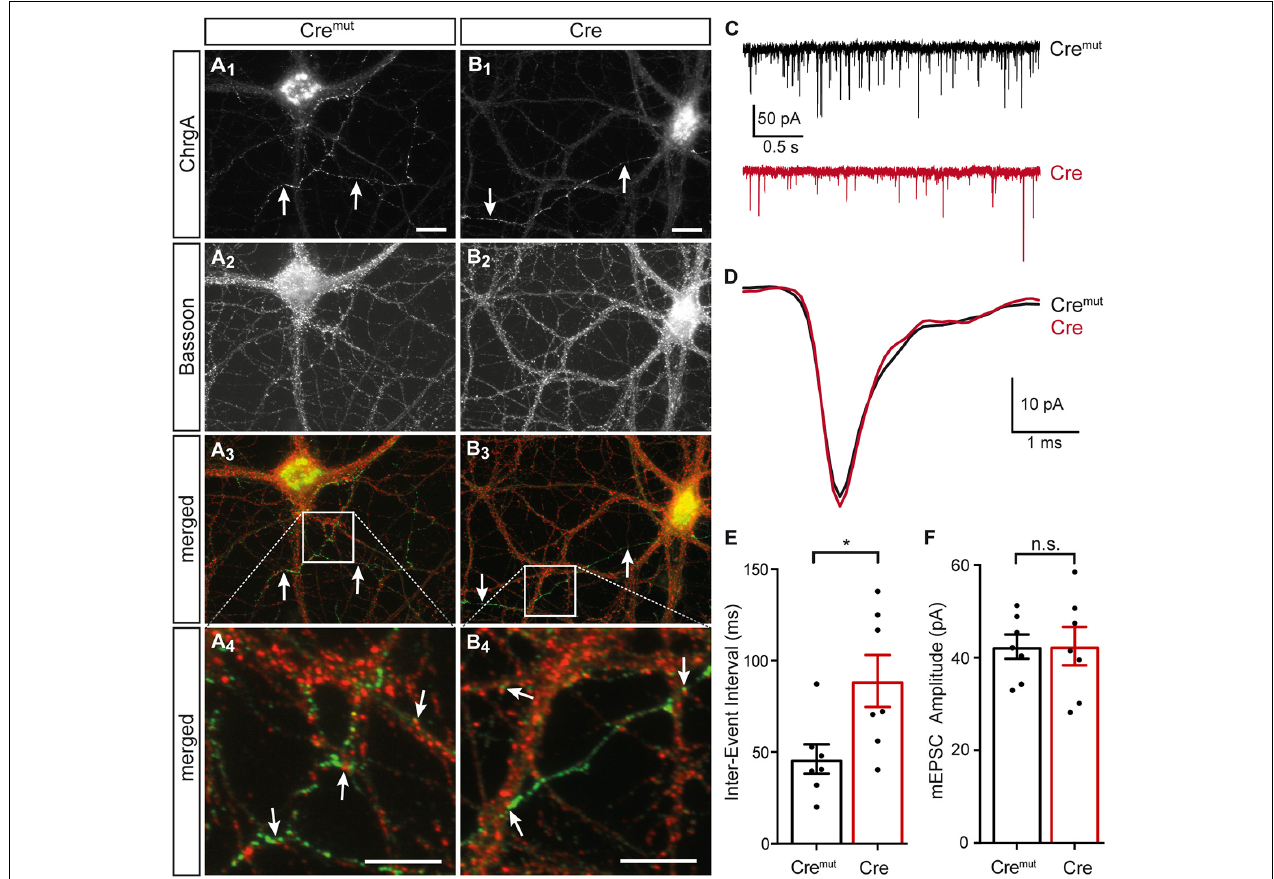
FIGURE 3 | Normal ChrgA-to-Bassoon alignment in synapses of β -Nrxn-deficient neurons. (A,B) Primary hippocampal neurons from floxed β -KI mice were transduced with lentivirus expressing inactive Cre mut (A 1 –A 4 ) or active Cre recombinase (B 1 –B 4 ) and immunostained at DIV18 with anti-ChrgA (arrows, A 1 ,B 1 ) and anti-Bassoon ( A 2 ,B 2 ). Merged images ( A 3 ,B 3 ) show the more restricted expression of the DCV marker ChrgA (arrows, green label) in comparison to the ubiquitous punctate distribution of the presynaptic marker Bassoon (red label). Note the juxtaposed localization of these molecules in high magnification images (arrows, A 4 ,B 4 ). Scale bars in panels (A 1 ,B 1 ) for panels (A 1 –A 3 ,B 1 –B 3 ) : 20 µ m; scale bars in panels (A 4 ,B 4 ) : 8 µ m. (C) Representative traces of whole-cell patch clamp recordings of pharmacologically isolated miniature excitatory postsynaptic currents (mEPSCs) show a visibly reduced frequency of mini events in β -Nrxn-deficient (Cre, red) neurons compared to controls (Cre mut , black). (D) Averaged individual mEPSC traces from more than 100 consecutive events reveal similar amplitudes and kinetics in β -Nrxn-deficient (Cre, red trace) neurons compared to controls (Cre mut , black trace). (E,F) The reduced mEPSC frequency in Cre neurons as shown in panel (C) is reflected by longer inter-event intervals (IEIs) (E) , whereas the mEPSC amplitude does not differ between genotypes (F) . Data are shown as mean ± SEM, dots indicate individual data points, measurements are based on n = 7 Cre mut control neurons with 647 mEPSC events (black bar) and n = 7 β -Nrxn-deficient Cre neurons with 575 mEPSCs (red bar) from the 3 independent cultures per genotype; significance difference indicated as *** p < 0.0001 or n.s. = non-significant, two-tailed unpaired t